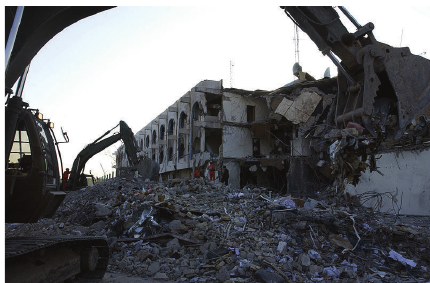
Figure 1: Destroyed reinforced concrete building by blast load [15].